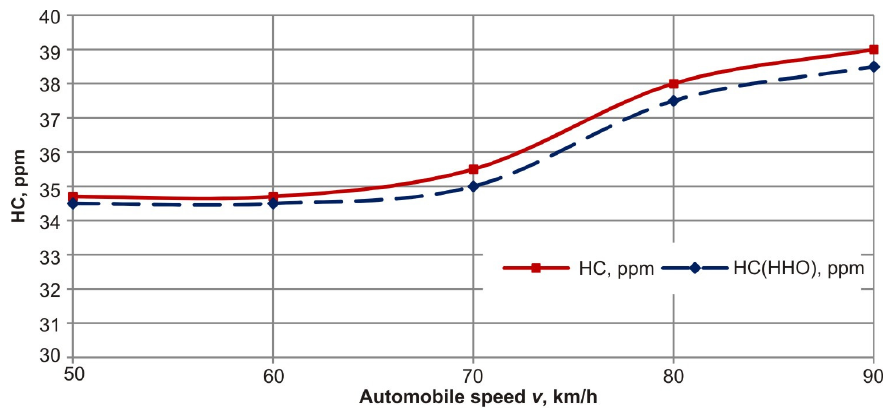
Fig. 4. Amount of HC in exhaust gases